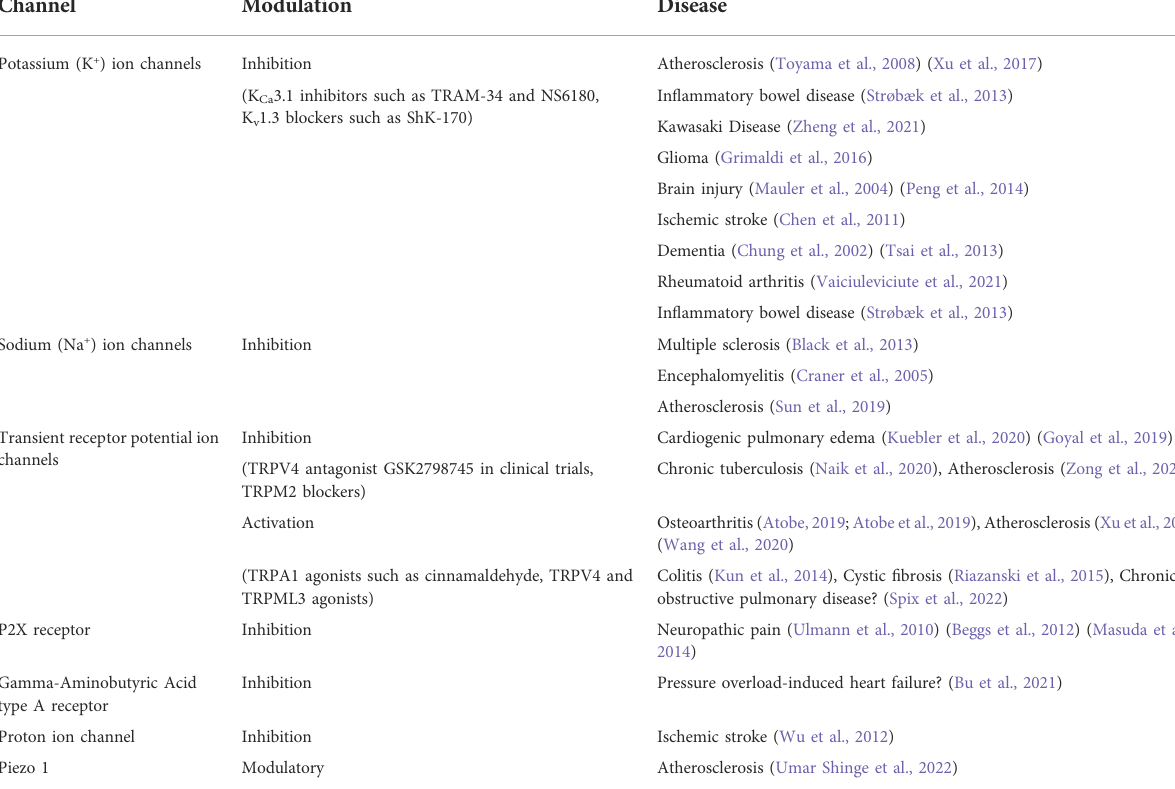
TABLE 5 Therapeutic opportunities for macrophage ion channel-targeted